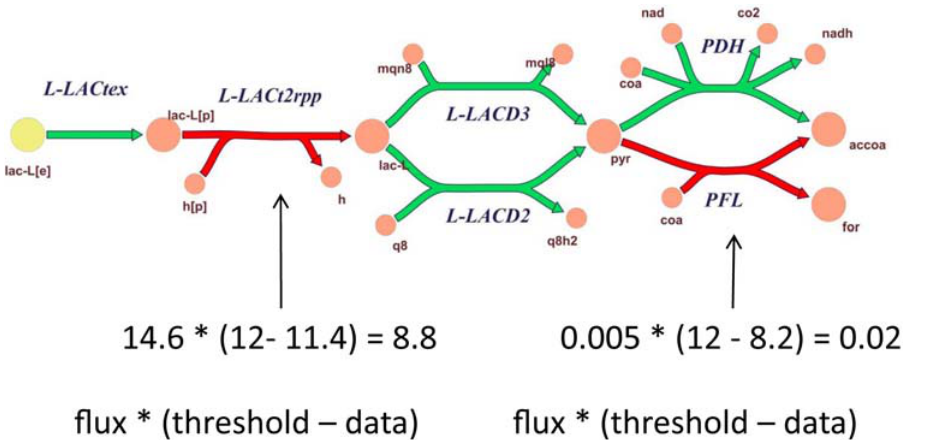
Figure 2. The computation of inconsistency scores. Inconsistency scores for each reaction are computed by multiplying the deviation from a threshold by the required flux through a reaction. In the example here, the green reactions have data above the threshold, set to 12 (this is a parameter; see text). The red reactions have data below the threshold (11.4 and 8.2). The calculation of the inconsistency score corresponding to each reaction is shown numerically as flux multiplied by the deviation from the cutoff. They each increase the inconsistency score, implying that the data are less consistent with the objective of growing on lactate. Greater required fluxes and greater deviation from the threshold both increase the inconsistency scores. The total inconsistency score is the sum of all individual reaction scores.